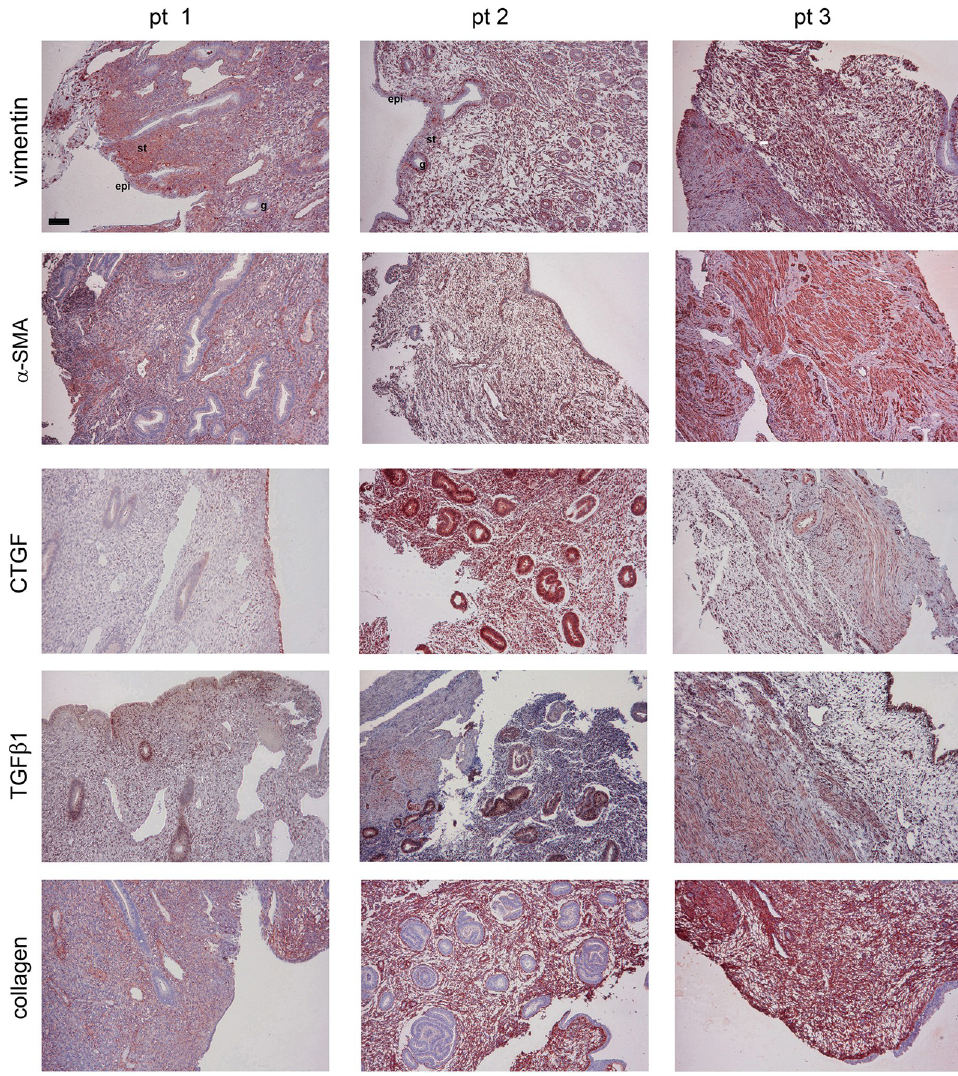
Fig 7. IHC of the expression patterns of (myo)fibroblast, TGF β 1, CTGF, and collagen in human adenomyotic endometrium specimens. The endometrium specimens from three individual patients (pts) were analyzed by IHC using the Abs raised against the indicated proteins. This was representative from three to four IHC results. Scale bar = 100 μ m.